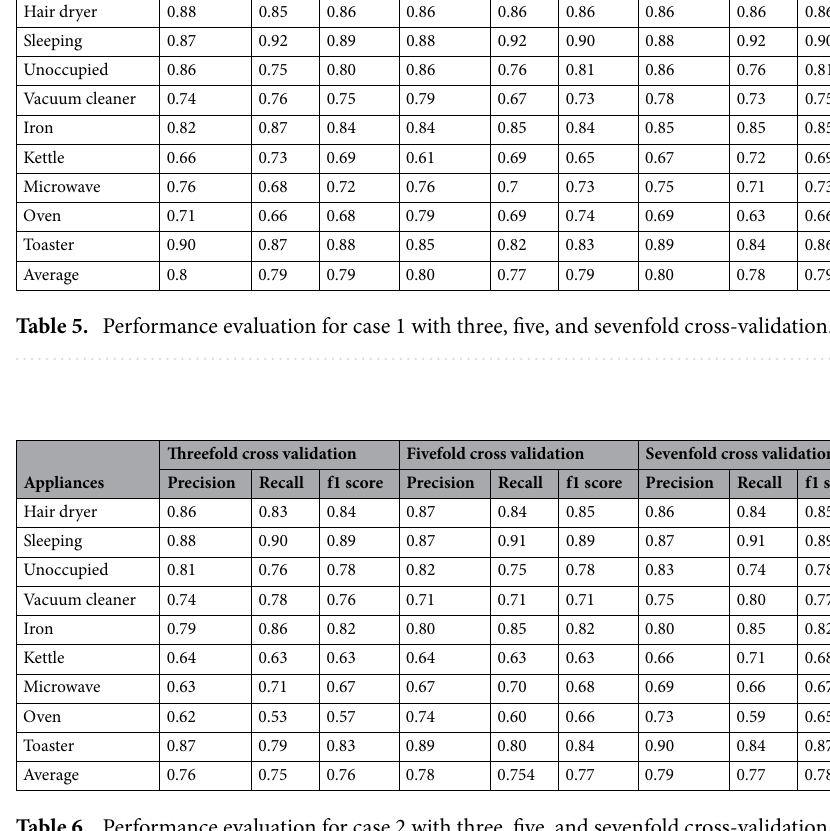
Table 6. Performance evaluation for case 2 with three, five, and sevenfold